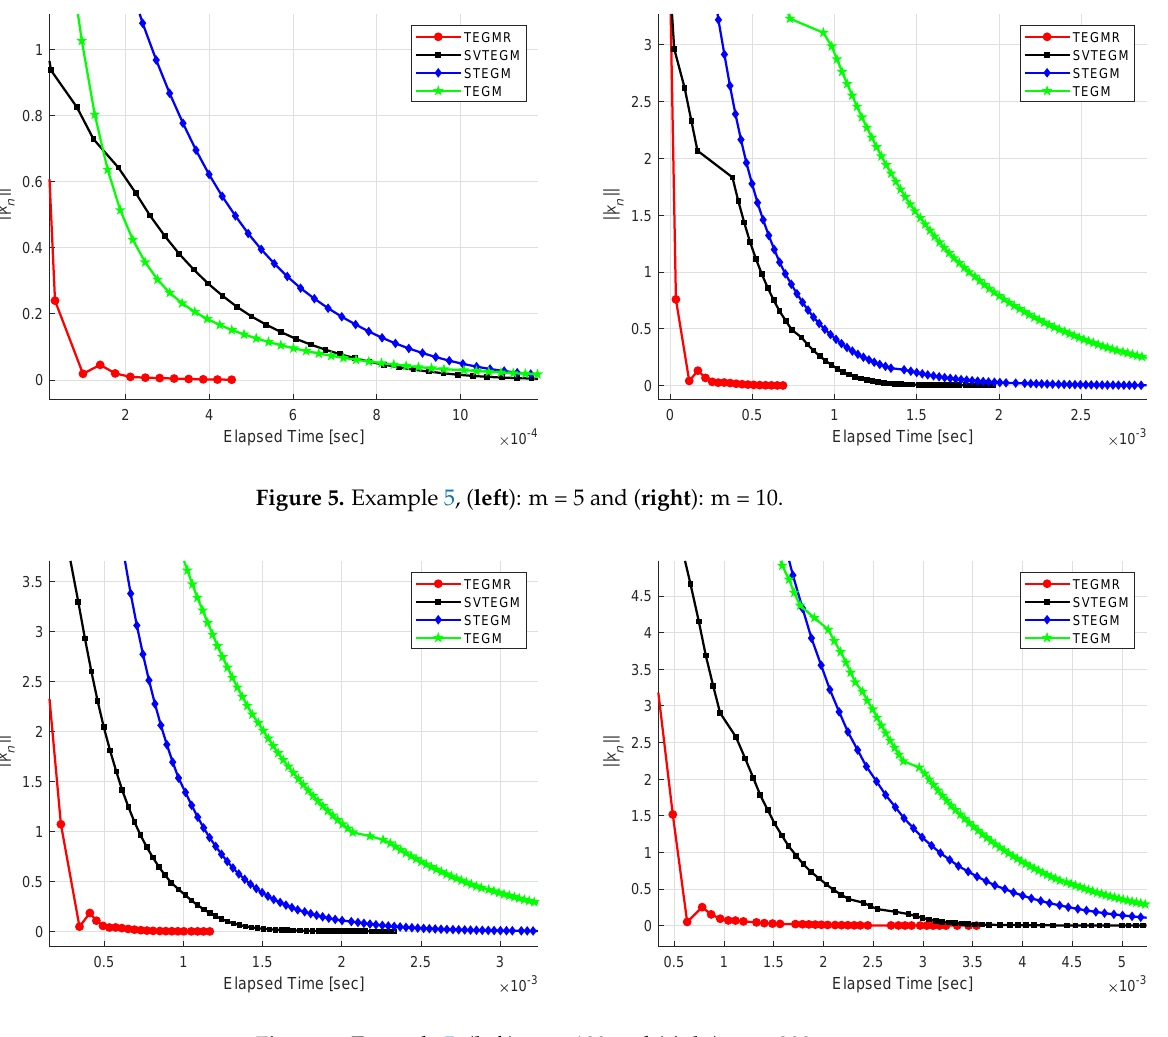
Figure 6. Example 5, ( left ): m = 100 and ( right ): m =